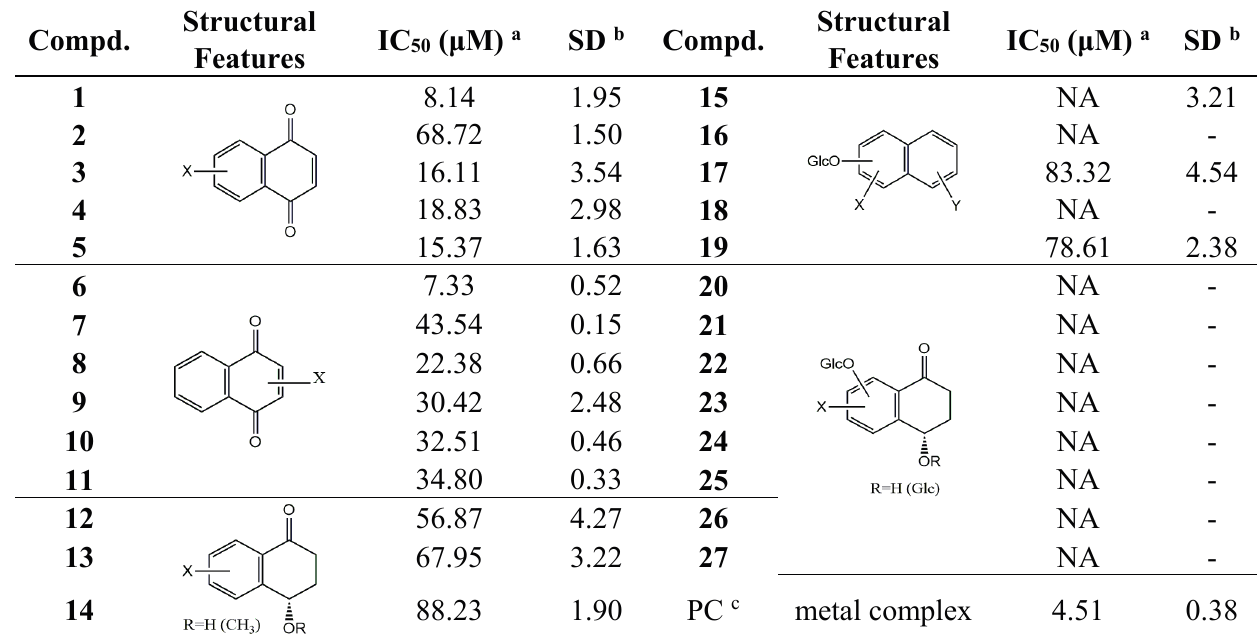
Table 2. Cytotoxicities of compound 1 – 27 from J. mandshurica Maxim on HepG-2 cells lines.